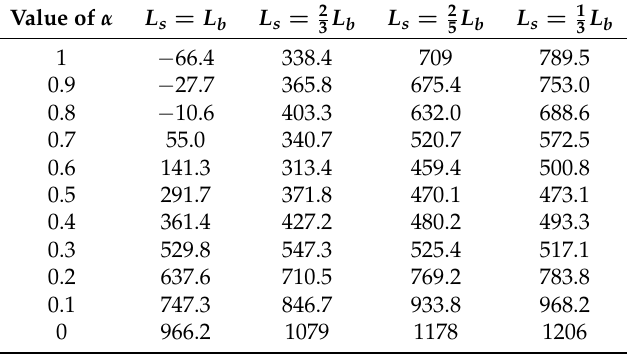
Table 6. Influence of different energy export prices, L b on the energy exchange costs. Note that these C ex , α values (in $/h) were obtained for Location C with a complementarity value of −